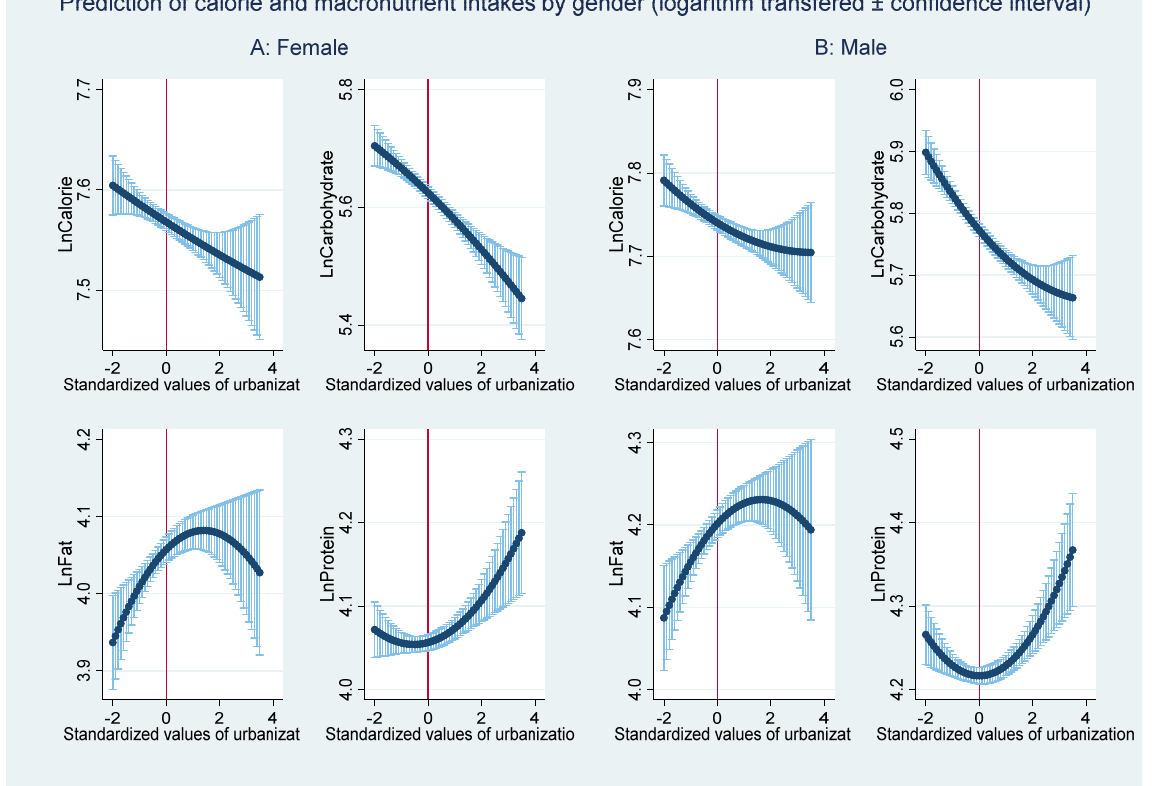
Nutrients 2021 , 13 , x FOR PEER REVIEW Figure 4. The relationship between urbanization and the predicted nutrition intakes by gender.